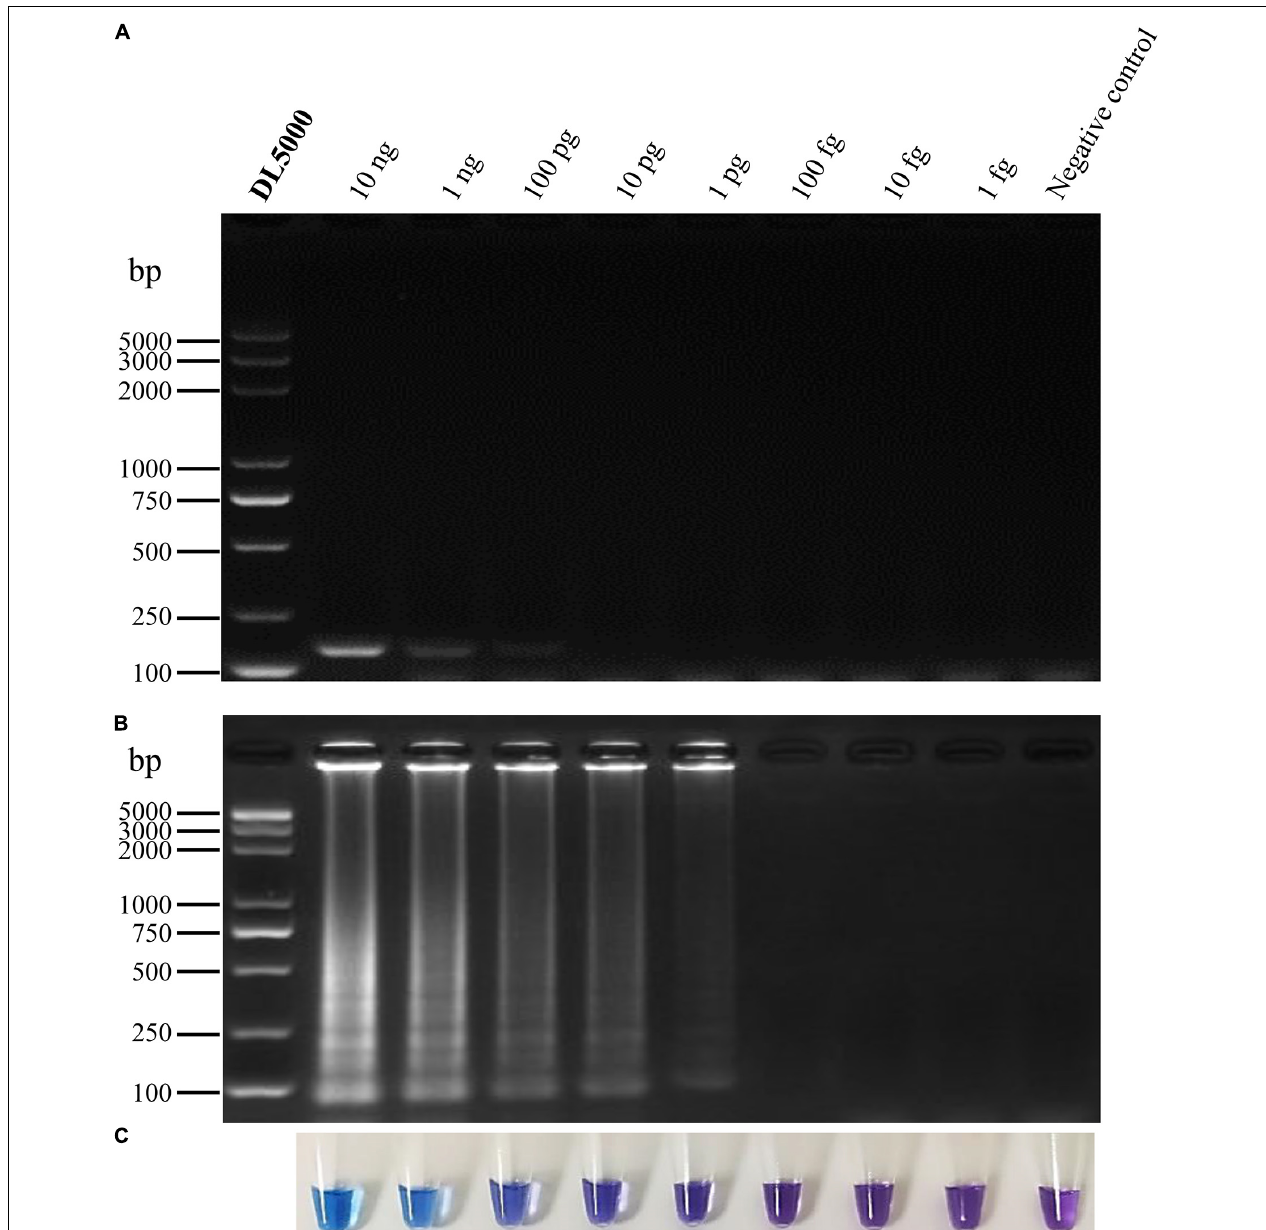
FIGURE 5 | Sensitivity of conventional PCR and the LAMP assays for detecting P. vexans . (A) Detection of conventional PCR products by agarose gel electrophoresis. (B) Detection of LAMP products by agarose gel electrophoresis. (C) Detection of LAMP products using HNB as a visual